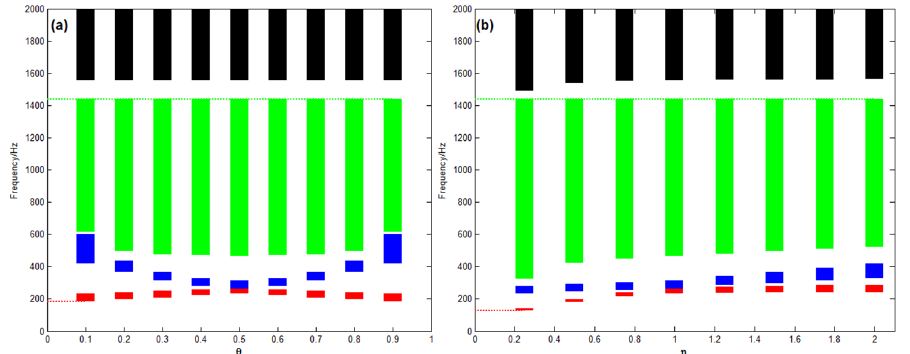
Figure 9. The bandgaps generated by the union of graded units, with the graded ranges of ( a ) θ ∈ [ 0.1,0.9 ] when η = 1 and ( b ) η ∈ [ 0.25,2 ] when θ =